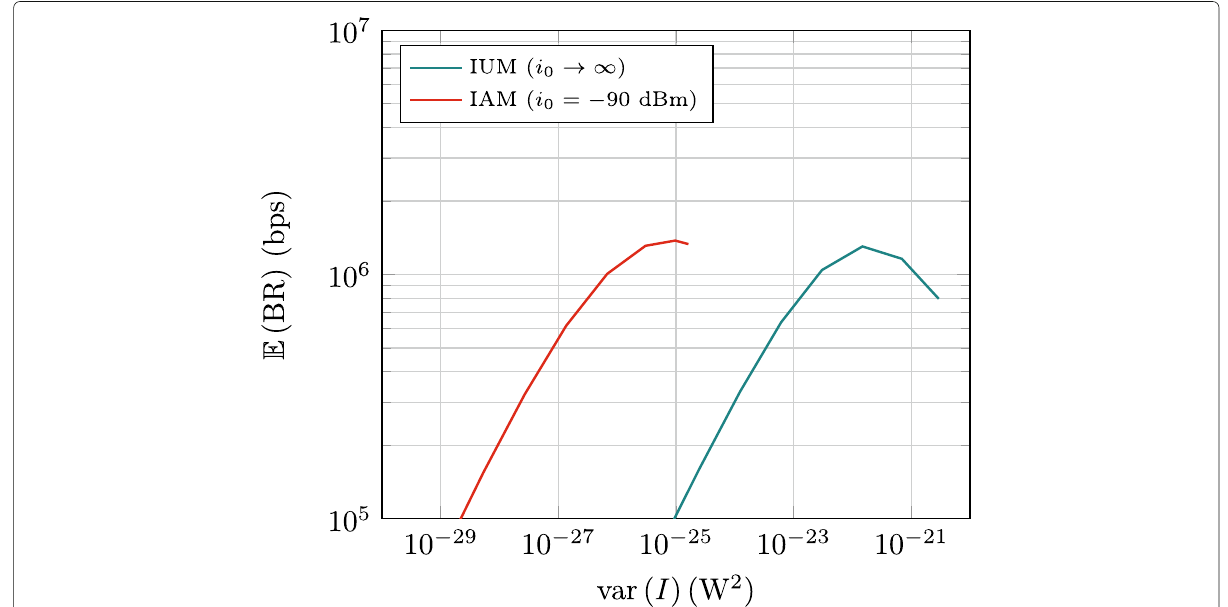
Fig. 10 Average BR as a function of the variance of the interference for IAM ( i 0 = − 90 dBm) and IUM ( i 0 → ∞ ) schemes with p max = 5 dBm and t ( 1 ) / t ( 2 ) = 9